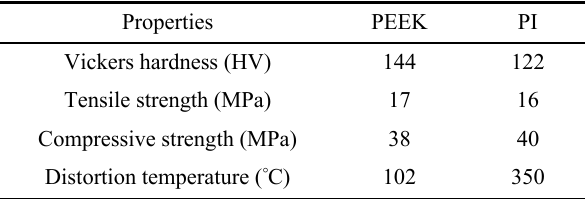
Table 3 Properties of PEEK and PI composite materials.